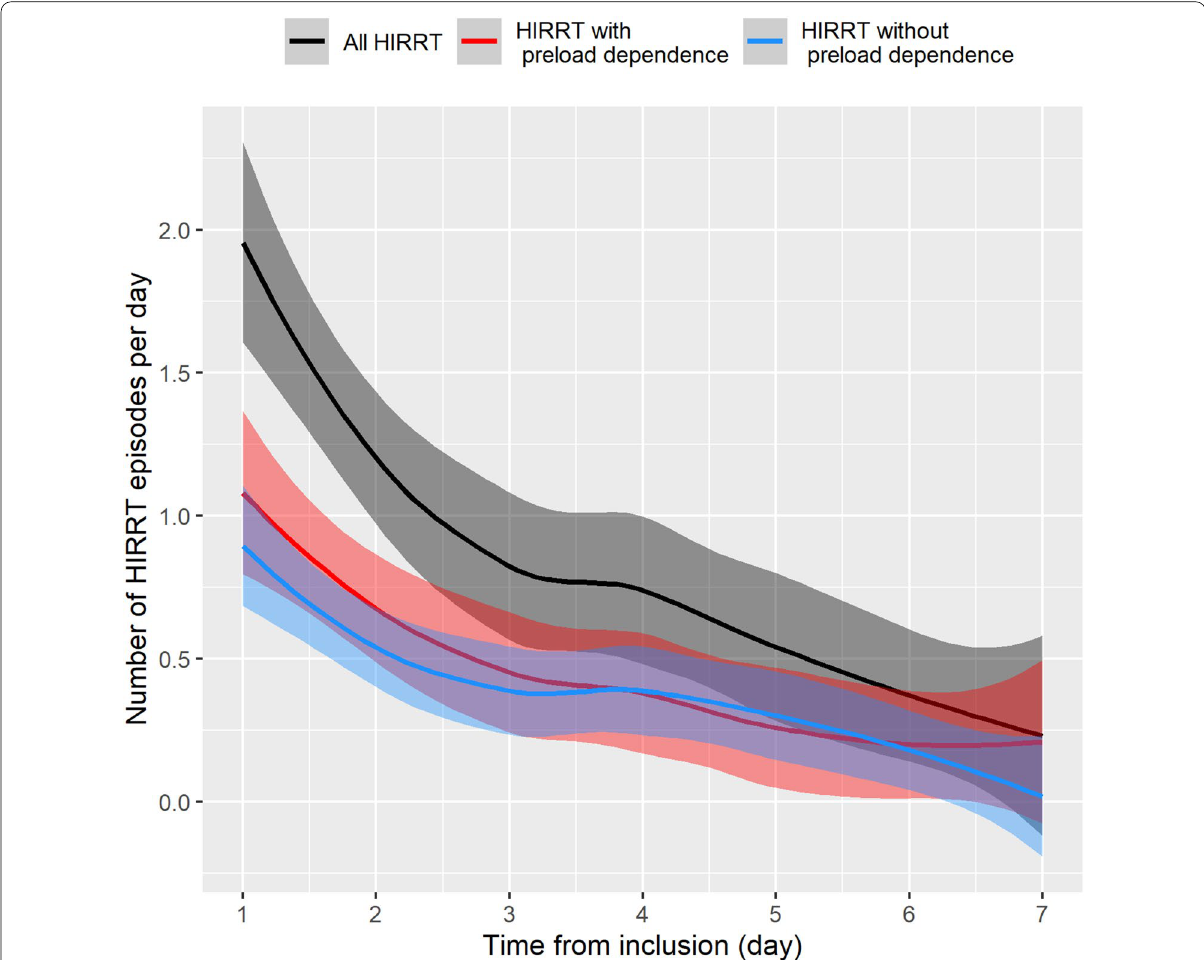
Fig. 3 Number of HIRRT episodes per day and per patient following inclusion. Continuous lines are local polynomial regression (LOESS) fits of individual data points. Shaded areas are 95% confidence level interval for predictions. HIRRT hemodynamic instability related to renal replacement